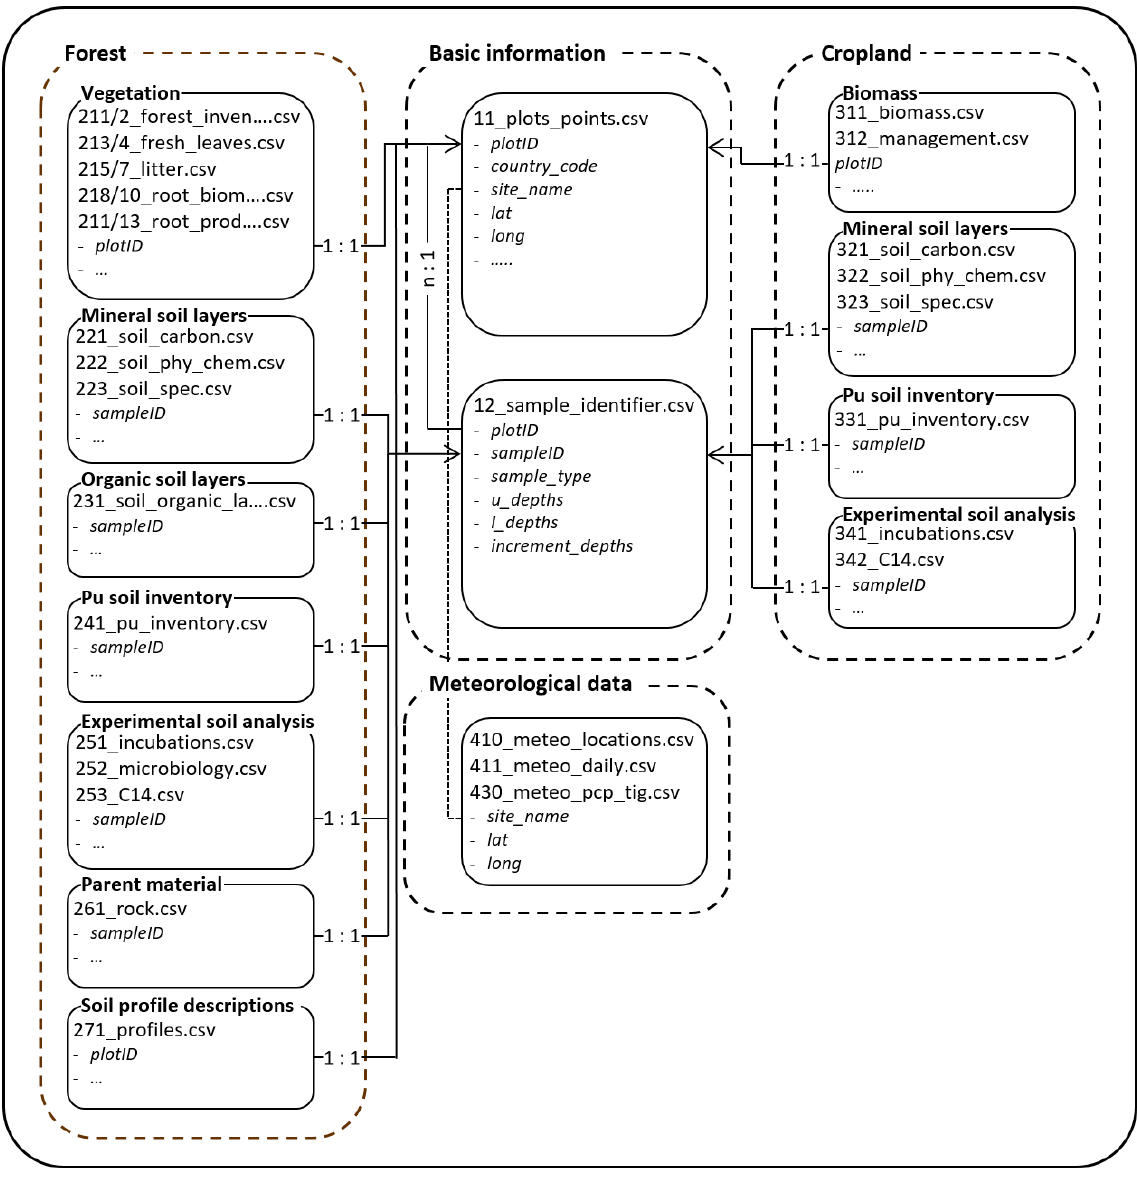
Figure 6. Overview of linkages between datasets in the TropSOC database v1.0. Note that for each data .csv file a .pdf file is given detailing the metadata of the respective data